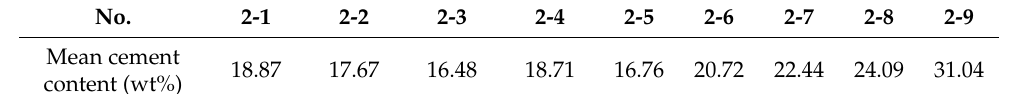
Table 4. The cement content values obtained for samples in row 2.